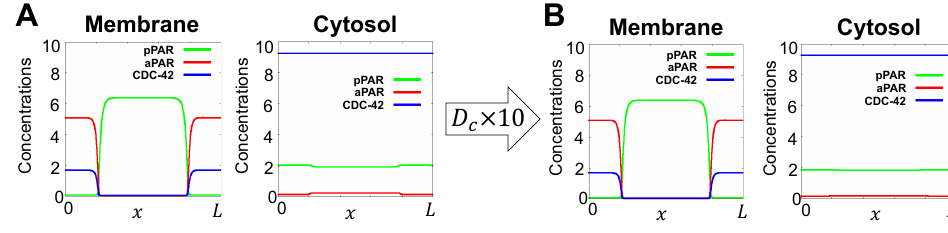
Figure A1. Simulations results for Model (1) on 1D. ( A ) The simulation results of Model (1) with biologically feasible cytosol diffusion coefficient. ( B ) The simulation results for the case where the cytosol diffusions are ten times larger than the case of ( A ). Both cases ( A ) and ( B ) show almost homogeneous concentrations for cytosol proteins and with a sufficiently large diffusion coefficient, we can assume that the asymptotic dynamics of cytosol proteins is homogeneous steady state. The simulation results are reported at 30 min and the detailed parameters are given in Table